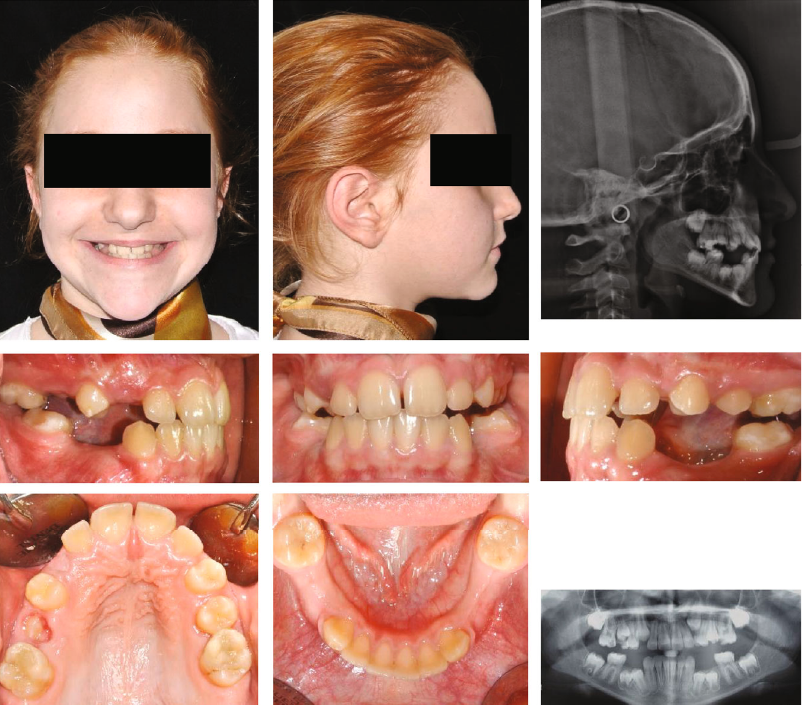
Figure 5: Case no. 1 tracings at T